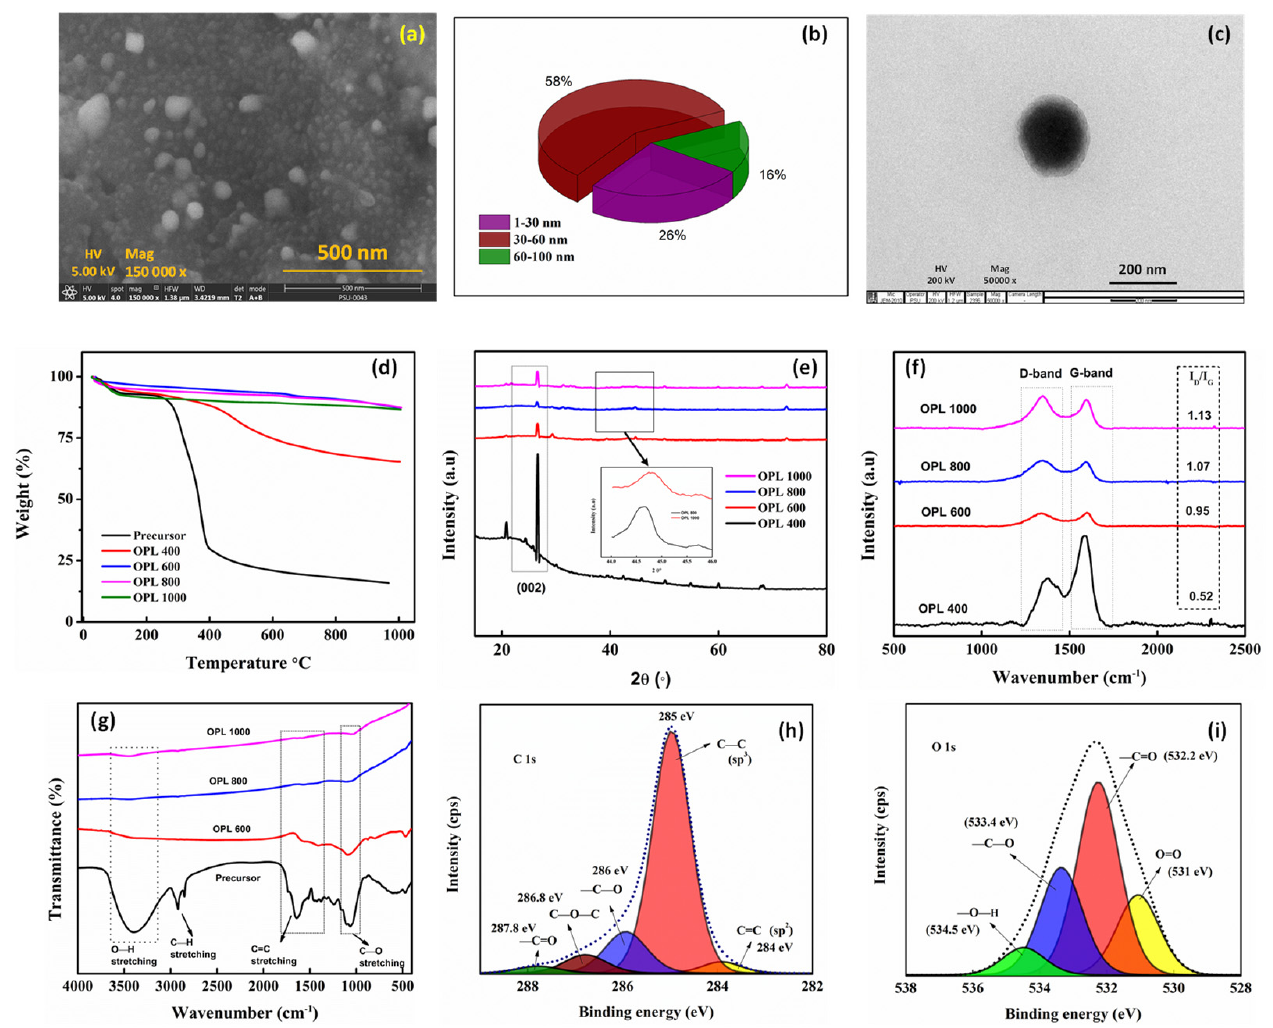
Figure 1. FESEM image of carbonized material synthesized at 1000 °C ( a ). CNSs size distribution obtained from FESEM image, depicted in a pie chart ( b ). TEM image of CNS ( c ). TGA of precursor and CNSs ( d ). XRD plot ( e ). Raman spectrum ( f ). FTIR spectrum of CNSs ( g ). Deconvoluted XPS spectra of C 1s ( h ). O 1s ( i ). The inset in 1e shows the magnified portion of OPL 800 and 1000 . Table 1. Elemental composition of OPL precursor and OPL derived CNSs.